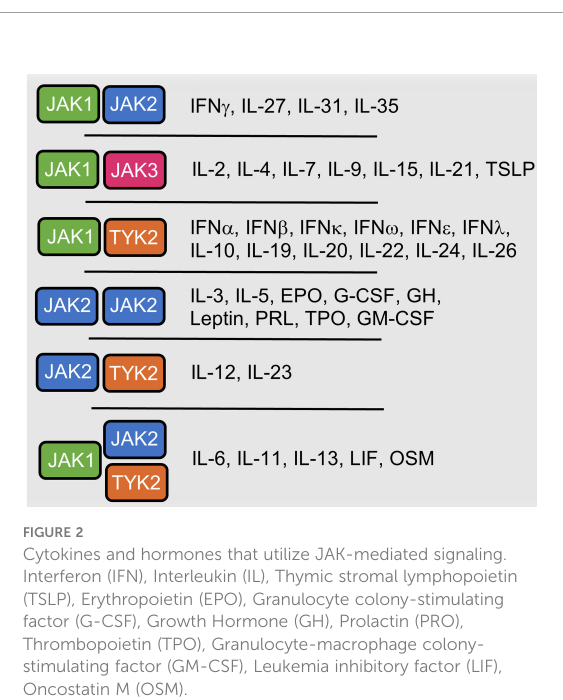
FIGURE 2 Cytokines and hormones that utilize JAK-mediated signaling. Interferon (IFN), Interleukin (IL), Thymic stromal lymphopoietin (TSLP), Erythropoietin (EPO), Granulocyte colony-stimulating factor (G-CSF), Growth Hormone (GH), Prolactin (PRO), Thrombopoietin (TPO), Granulocyte-macrophage colony- stimulating factor (GM-CSF), Leukemia inhibitory factor (LIF), Oncostatin M